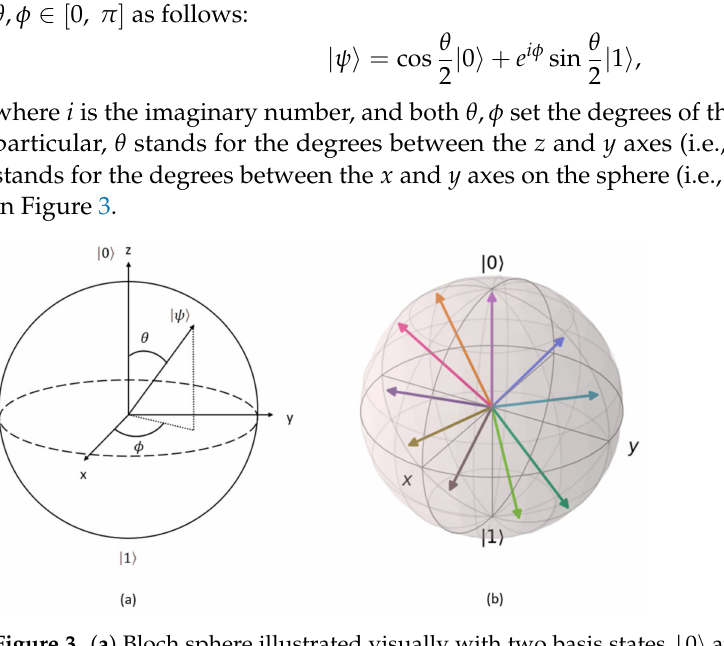
Figure 3. ( a ) Bloch sphere illustrated visually with two basis states |0 〉 and |1 〉 and a state vector | ψ 〉 . ( b ) Bloch sphere with ten vectors representing all ten emotional motivator classes. Note that all their ten orthogonal vectors are omitted for